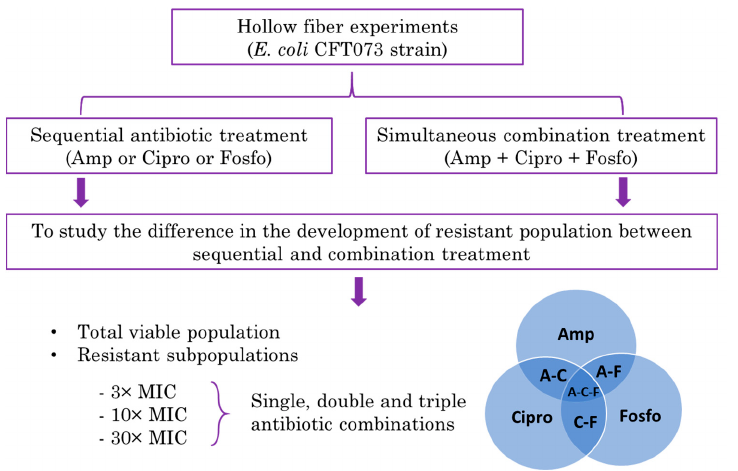
Figure 1. Schematics representing the hollow fiber infection model (HFIM) study comparing the sequential antibiotic treatment with the combination antibiotic treatment in delaying the resistance emergence.